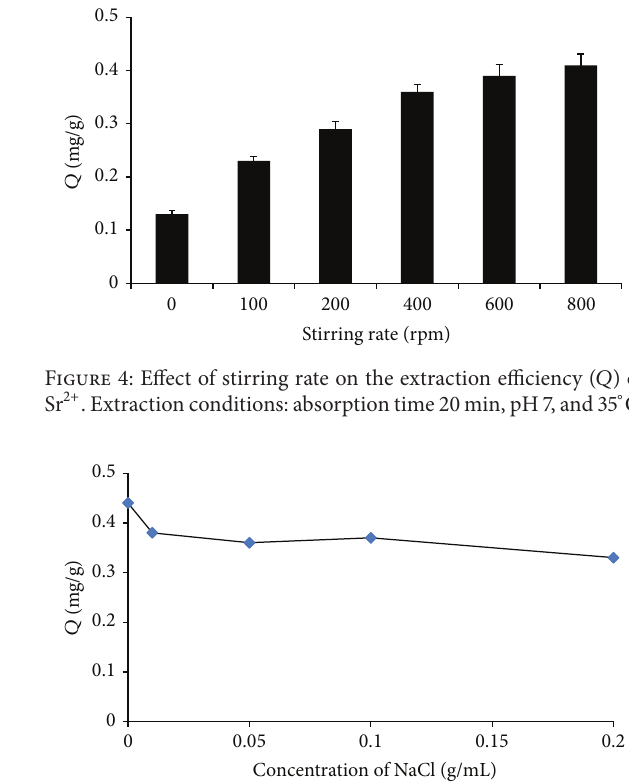
Figure 5: Effect of NaCl concentration on the extraction efficiency ( 𝑄 ) of Sr 2+ . Extraction conditions: absorption time 20min, pH 7, 35 ∘ C, and stirring rate 600